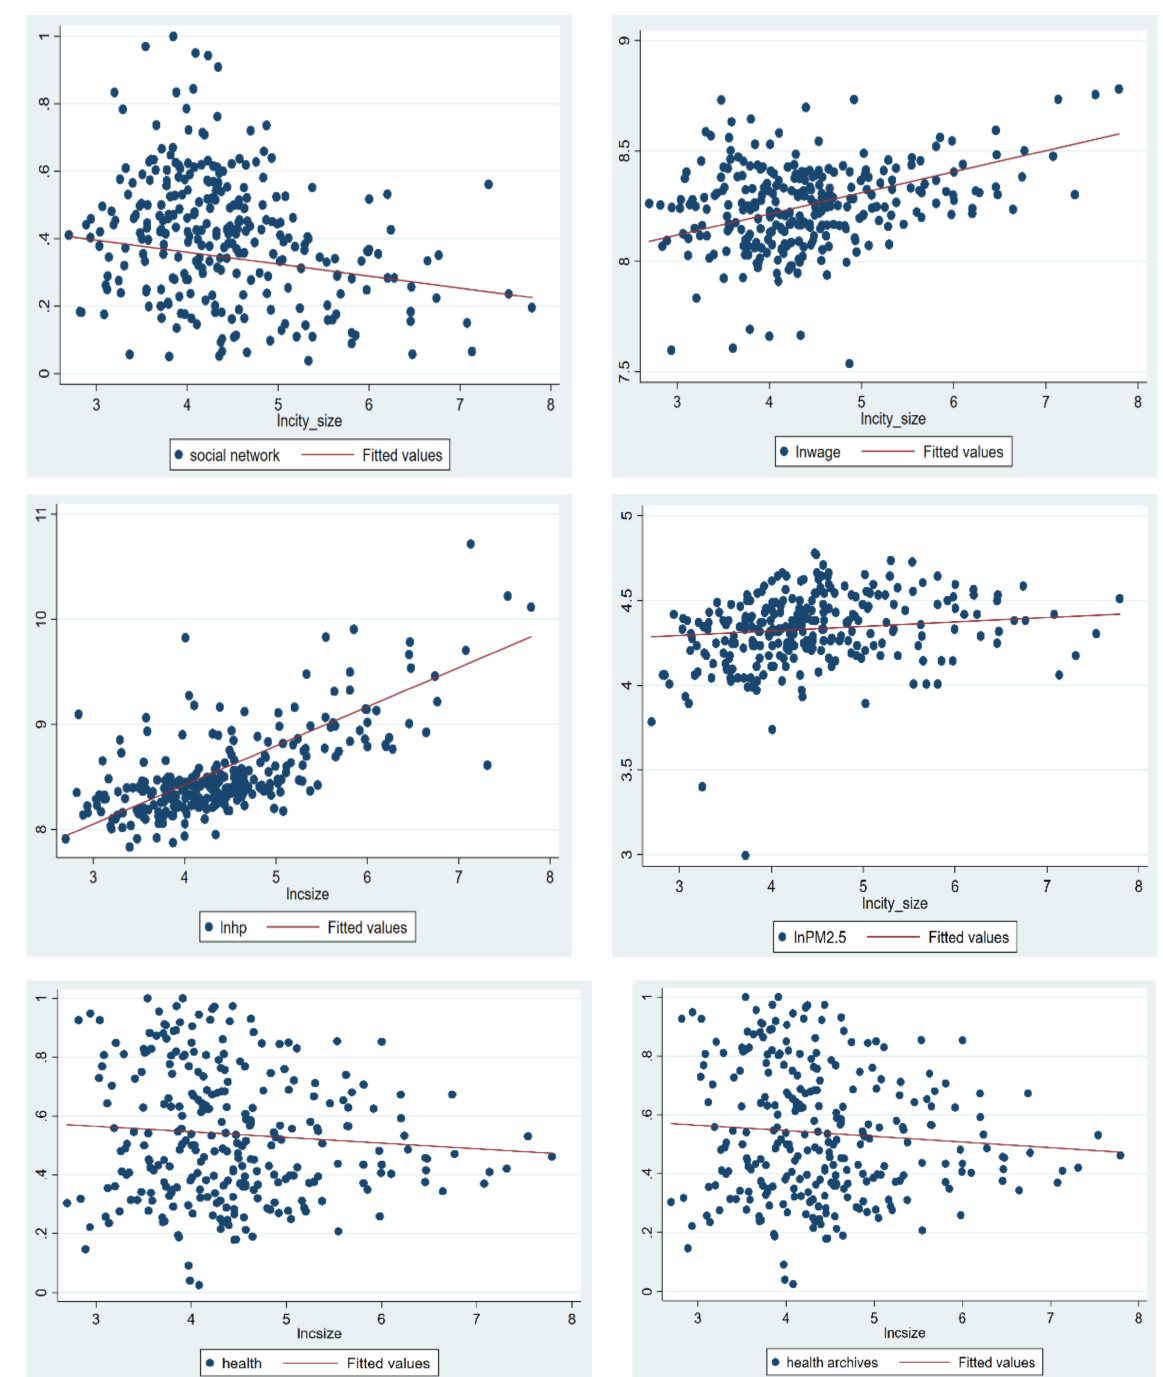
Figure 3. The spatial agglomeration economics and crowding effect of city